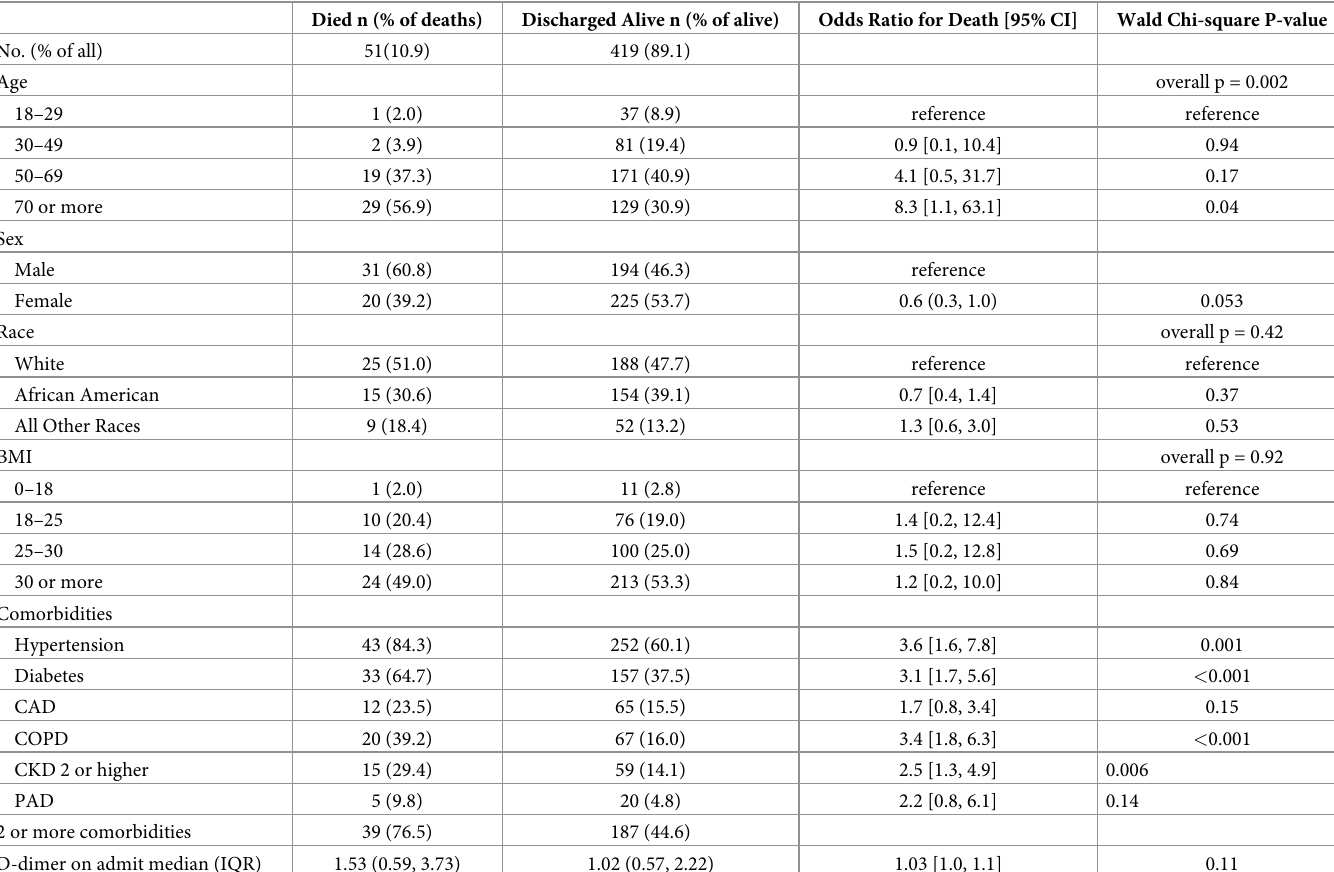
Table 2. Demographic factors associated with mortality among COVID-19 subjects admitted to the hospital or emergency